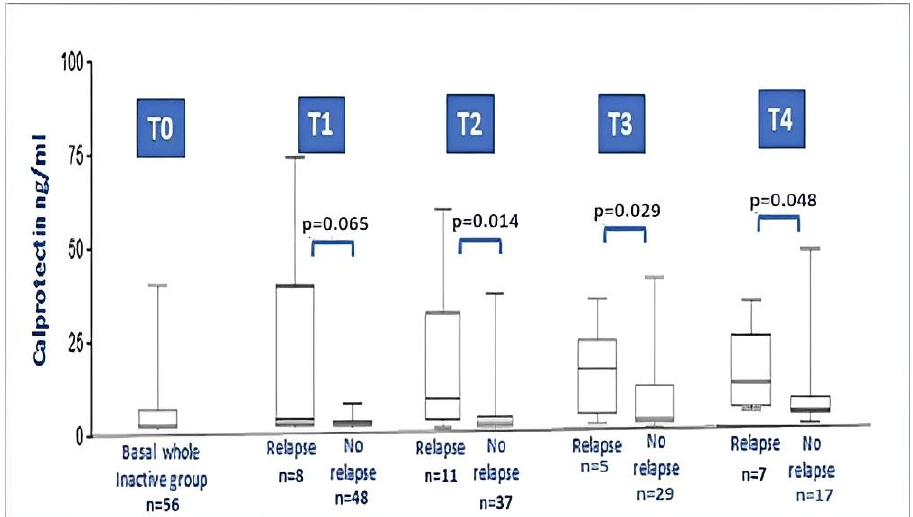
Figure 3. Calprotectin levels in the whole JIA inactive group at baseline and after 3, 6, 12 and 18 months follow-up (relapsers vs. non relapse at each timepoint). At timepoint 2, 3 and 4, the difference between levels of calprotectin in relapser vs. non-relapsers was significant (Mann–Whitney test).